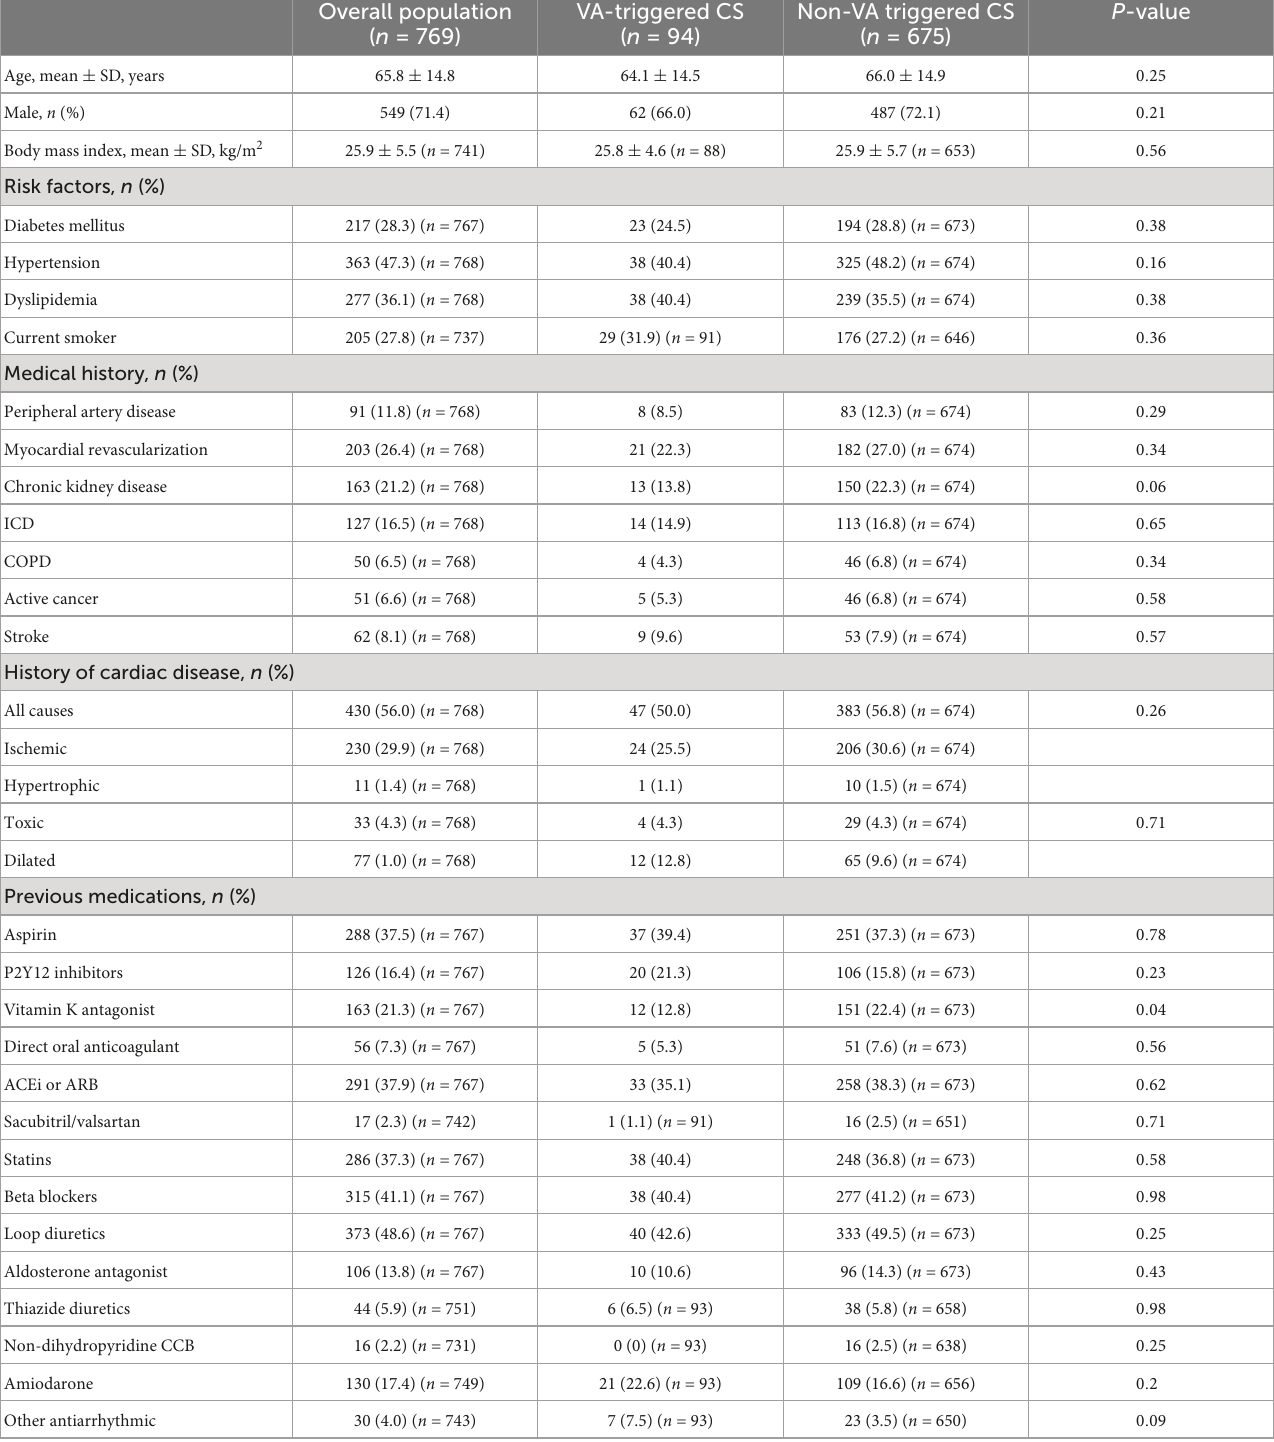
TABLE 1 Baseline characteristics at admission according to cardiogenic shock triggers (VA versus